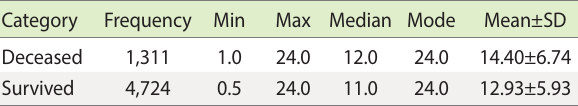
Table 3. Average usage time (hour) per day of humidifier disinfect- ants